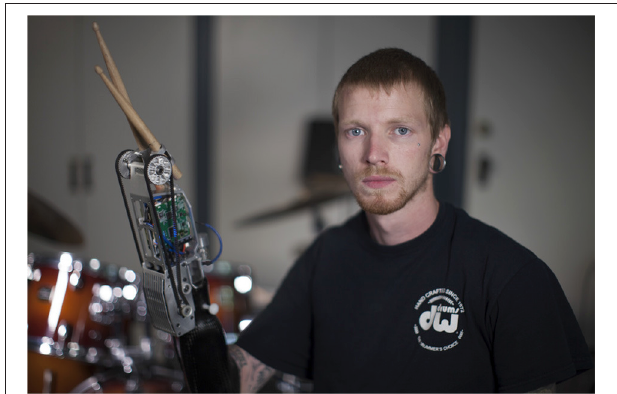
FIGURE 1 | Jason Barnes— The drummer is wearing a prosthesis with actively controlled drumsticks on the stump. The rebound of the drumstick is tuned by using a DC motor in a variable-impedance shared-control framework. Picture by Lwp Kommunikáció (2014). License: CC-BY 2.0.